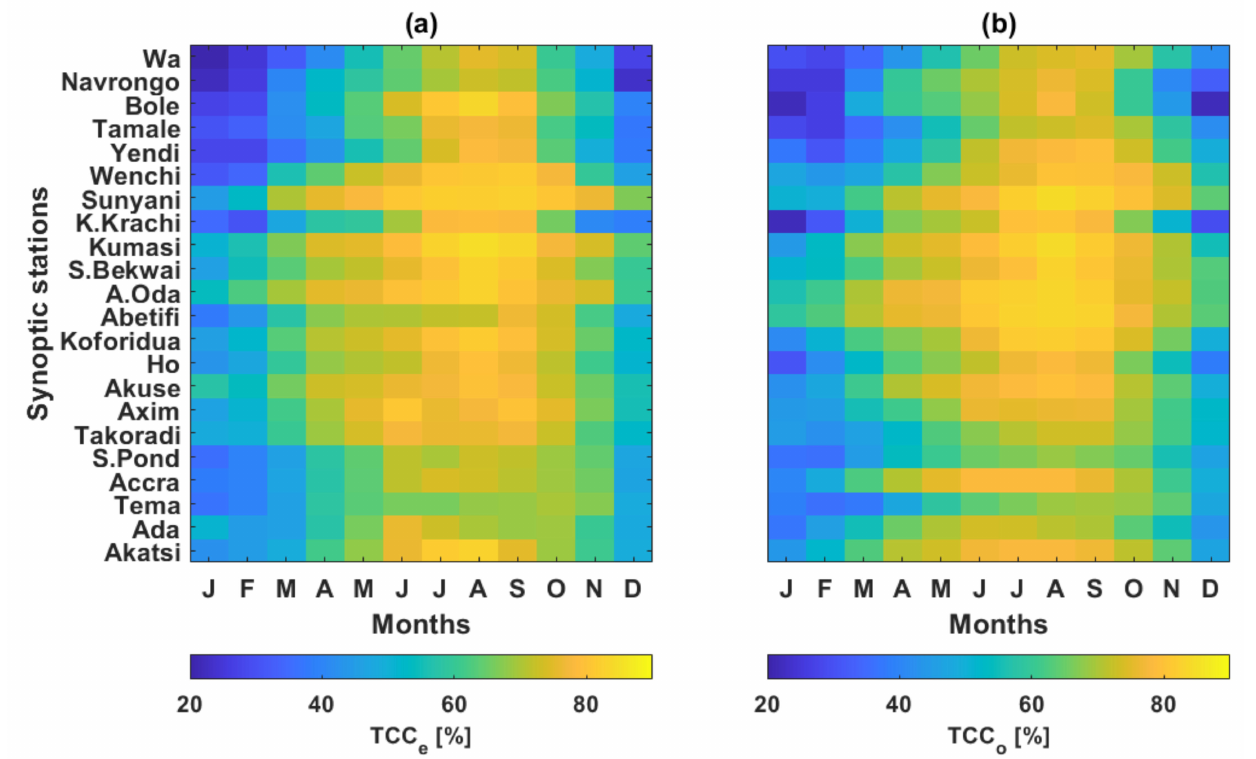
Figure 3. Comparing the spatiotemporal distribution of monthly mean TCC derived from ( a ) bias corrected model prediction and ( b ) station observation datasets at the 22 synoptic stations across the study